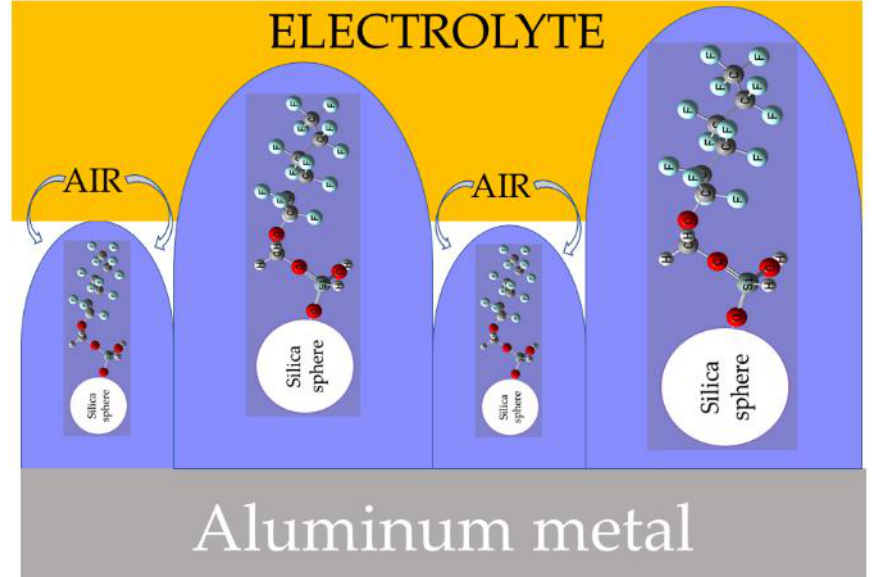
Figure 25. Model of an interface between the superhydrophobic and salt solution to explain the increased resistance to corrosion and hydrophobicity.